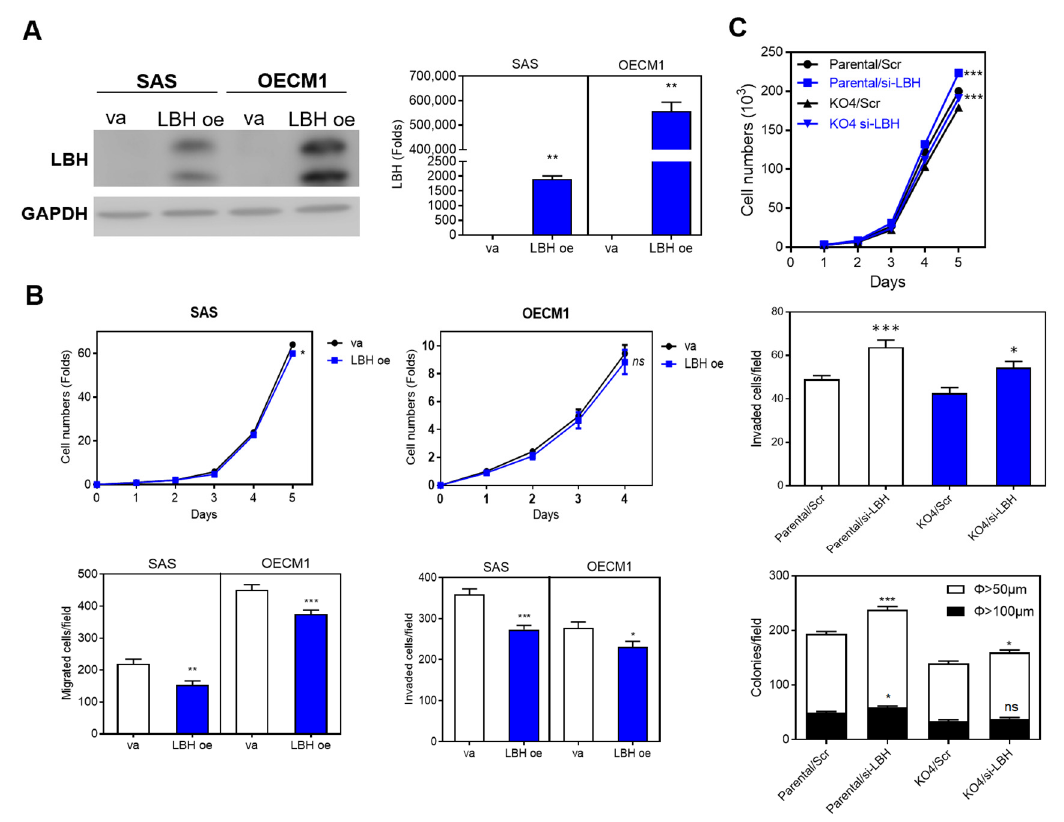
Figure 7. LBH suppresses the migration and invasion of OSCC cells. ( A ) Transient LBH overexpression in OSCC cells. Left, Western blot analysis. Only very brief exposure was carried out to acquire the images without a burn-through effect, this means that endogenous LBH expression is barely detectable. Right, qRT-PCR analysis shows increased LBH mRNA expression following transient overexpression. ( B ) Upper, proliferation; Lower Left, migration; Lower Right, invasion. The LBH expression in OSCC cells decreases migration and invasion by OSCC cells, but it does not affect proliferation of OSCC cells. ( C ) Knockdown of LBH reverts the phenotypes that resulted from MIR31HG deletion. Upper, proliferation; Middle, migration; Lower, anchorage-independent colony formation. va, vector alone; LBH oe, transient LBH overexpression. *, p < 0.05; **, p < 0.01; ***, p < 0.001.